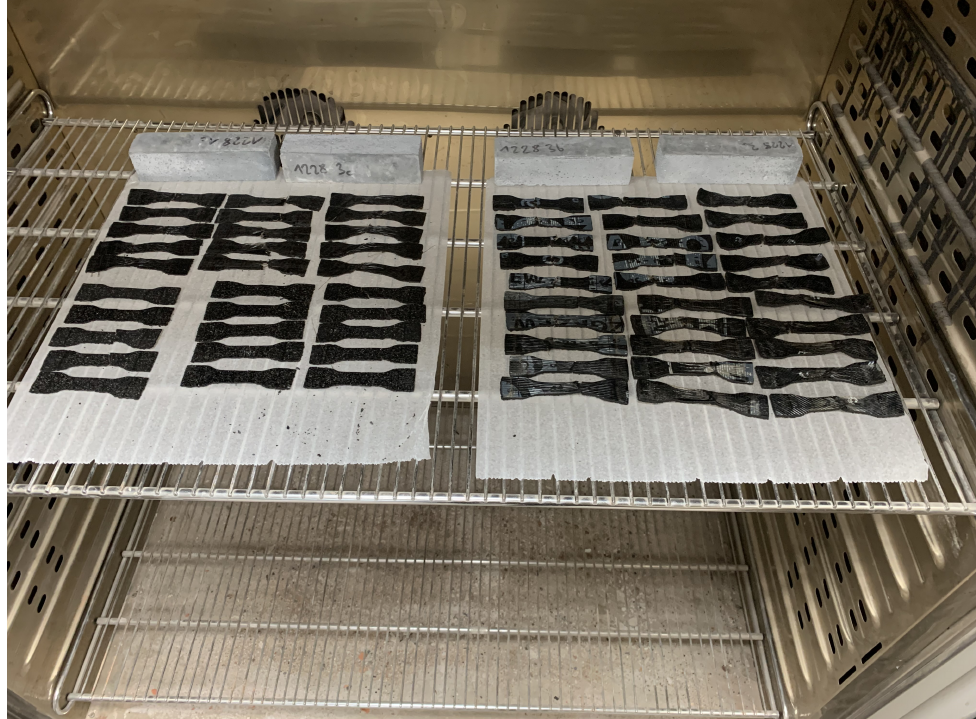
Figure 4. Samples in the climate chamber, arrangement before the